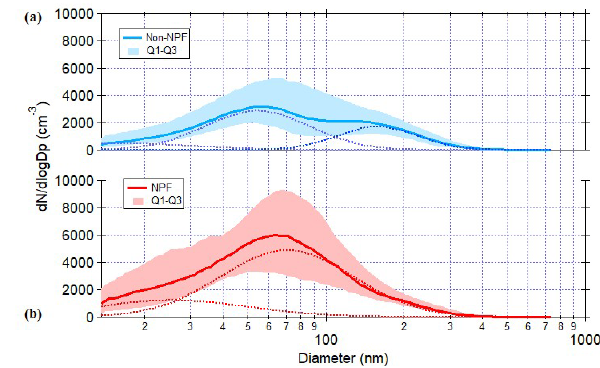
Figure 6. Particle size distribution (PSD) observed for NPF and non-NPF events. Solid lines: median; shadow: first and third quar- tiles; dashed lines: fitted